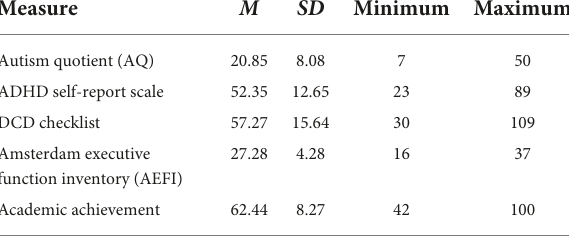
TABLE 1 Means, standard deviations, and range of scores across each measure.